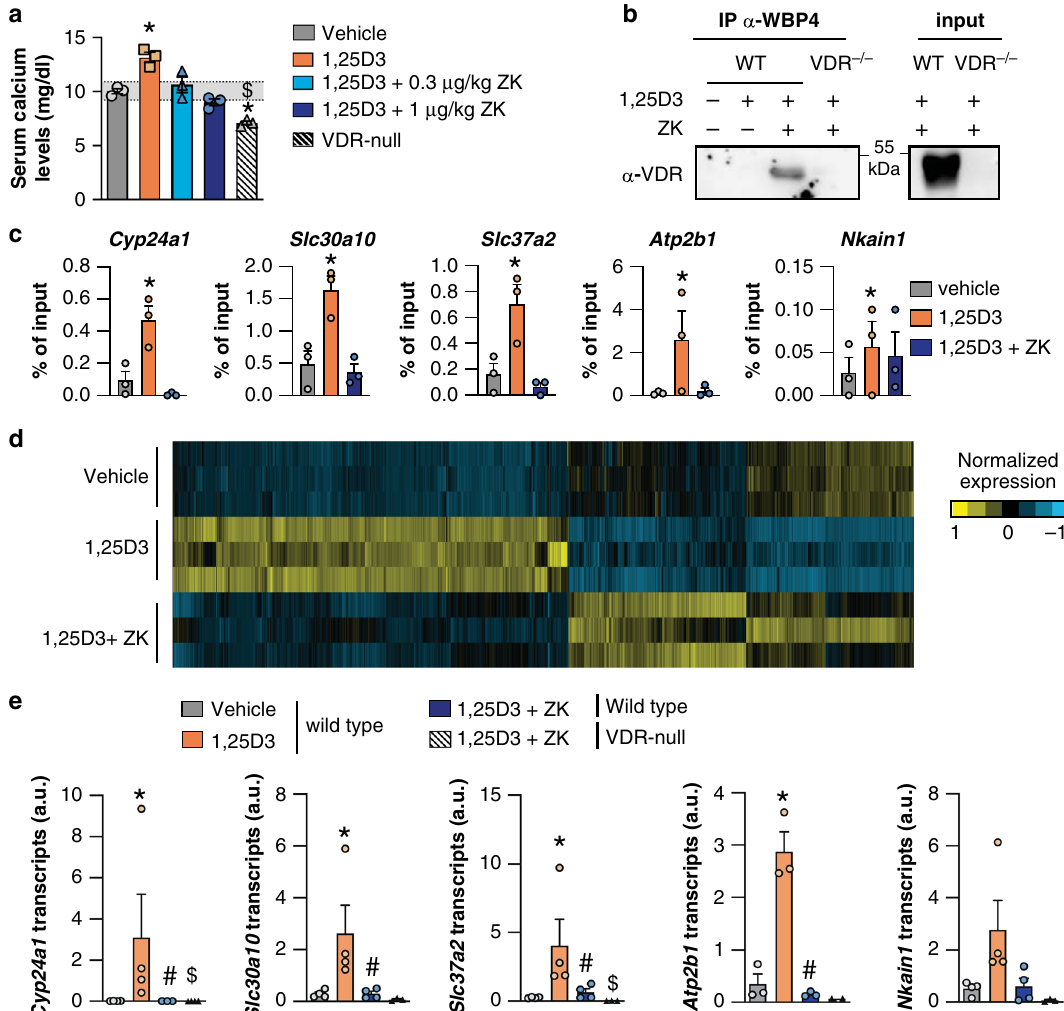
Fig. 5 ZK activities in mice. a Wild type mice were daily treated per os for 4 days with 1 µ g/kg 1,25D3, 1 µ g/kg 1,25D3 and 0.3 µ g/kg ZK, 1 µ g/kg 1,25D3 and 1 µ g/kg ZK or vehicle, and serum calcium levels were determined 24 h after the last administration. The gray area represents the normocalcemic range. Age-matched VDR-null mice were used as hypocalcemic controls. n = 3 mice/condition. b Representative immunoblot of VDR in WBP4 immunoprecipitated (IP- α WBP4) or in total (input) extracts from kidney of wild type mice treated for 6 h with vehicle, 1 µ g/kg 1,25D3, or 1 µ g/kg 1,25D3 and 1 µ g/kg ZK, and of VDR-null mice treated with 1 µ g/kg 1,25D3 and 1 µ g/kg ZK. Unprocessed blots in Source Data. c VDR ChIP-qPCR analysis of DNA segments encompassing vitamin D response elements of Cyp24a1 , Slc30a10 , Slc37a2 , Atp2b1 , and Nkain1 from duodenum of wild type mice treated for 1.5 h with vehicle, 1 µ g/kg 1,25D3, and 1 µ g/kg 1,25D3 and 1 µ g/kg ZK. n = 3 mice/condition. d Heatmap representing the mean-centered normalized transcript levels that were signi fi cantly different in the intestine of mice treated with 1,25D3 or with 1,25D3 and ZK, compared to vehicle. n = 3 mice/condition. e Cyp24a1 , Slc30a10 , Slc37a2 , Atp2b1 and Nkain1 transcript levels in duodenum of wild type mice treated for 6 h with vehicle, 1 µ g/kg 1,25D3, and 1 µ g/kg 1,25D3 and 1 µ g/kg ZK, and in VDR-null mice treated with 1 µ g/kg 1,25D3 and 1 µ g/kg ZK. n = 4 wild type mice/condition, except for Atp2b1 ( n = 3). n = 3 VDR-null mice/condition, except for Atp2b1 ( n = 2). Data in ( a ), ( c ), and ( e ) are represented as mean + s.e.m. * p < 0.05 vs. vehicle, # p < 0.05 vs. 1,25D3, $ p < 0.05 vs. 1,25D3 and ZK, one-way ANOVA with Tukey post-hoc test. The exact signi fi cant p -values are provided in Supplementary Table 4.